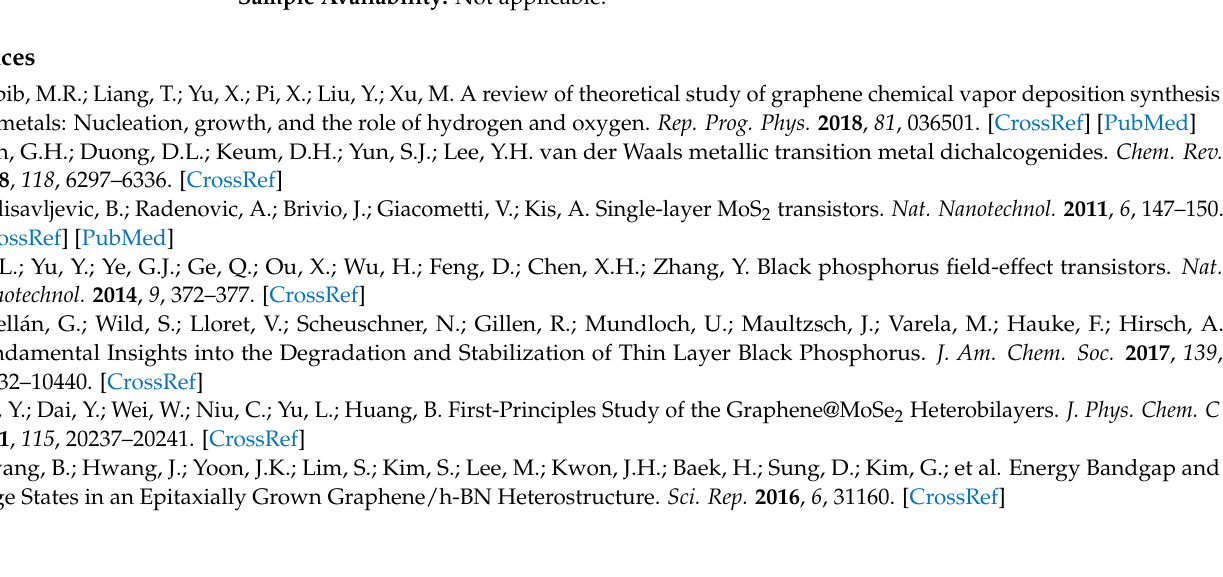
Figure S2: The spin-resolved band structure of 1Fe@(G/MoS 2 ), Figure S3: Optimized structures of two V atoms at different adsorption sites in the G/MoS 2 gap, Figure S4: Optimized structures of two Cr atoms at different adsorption sites in the G/MoS 2 gap, Figure S5: Optimized structures of two Mn atoms at different adsorption sites in the G/MoS 2 gap, Figure S6: Optimized structures of two Fe atoms at different adsorption sites in the G/MoS 2 gap, Figure S7: Optimized structures of three V atoms at different adsorption sites in the G/MoS 2 gap, Figure S8: Optimized structures of three Cr atoms at different adsorption sites in the G/MoS 2 gap, Figure S9: Optimized structures of three Mn atoms at different adsorption sites in the G/MoS 2 gap, Figure S10: Optimized structures of three Fe atoms at different adsorption sites in the G/MoS 2